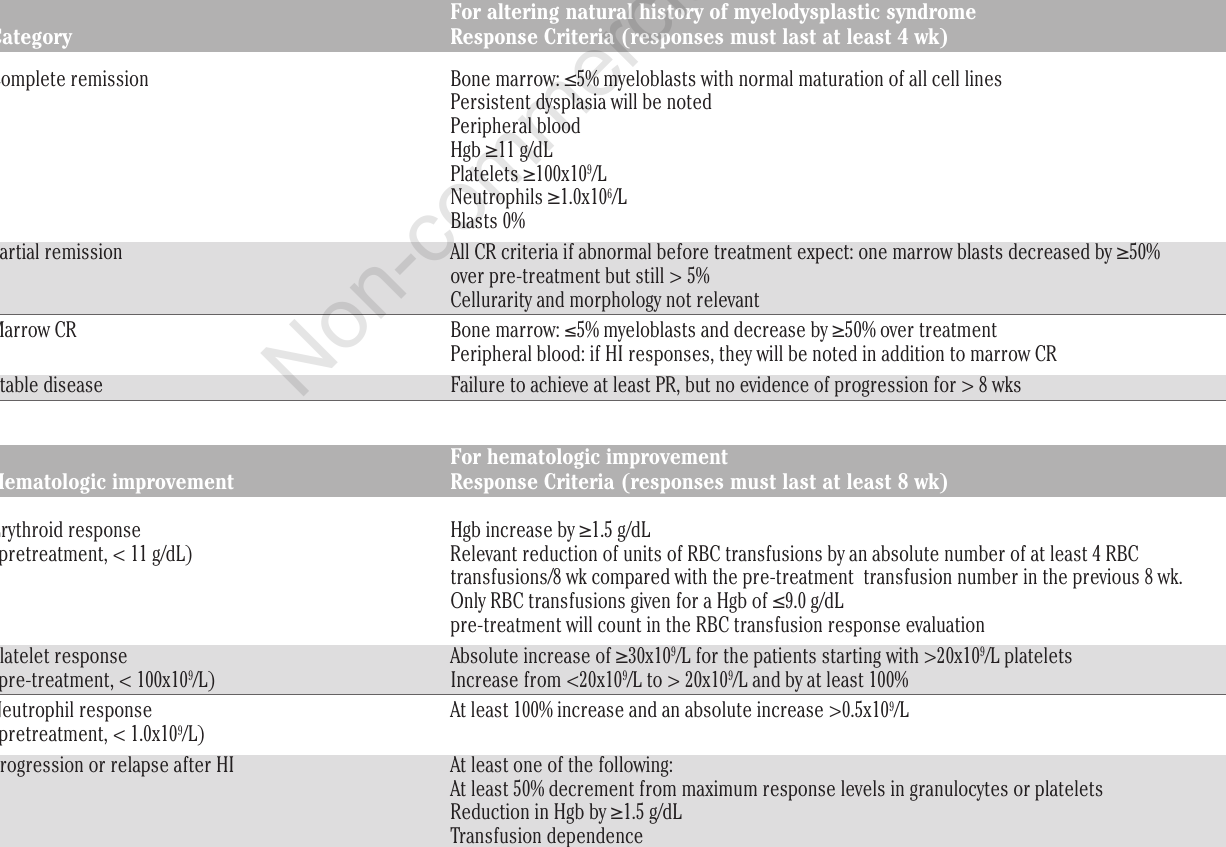
Table 2. Proposed modified International Working Group response criteria. For altering natural history of myelodysplastic syndrome Category Response Criteria (responses must last at least 4